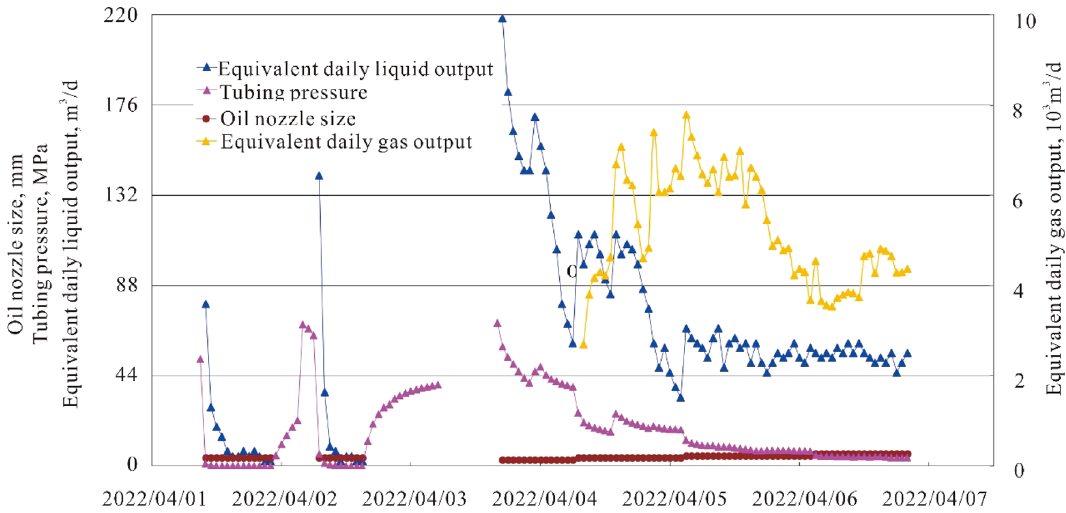
Fig. 11 Output profile of well